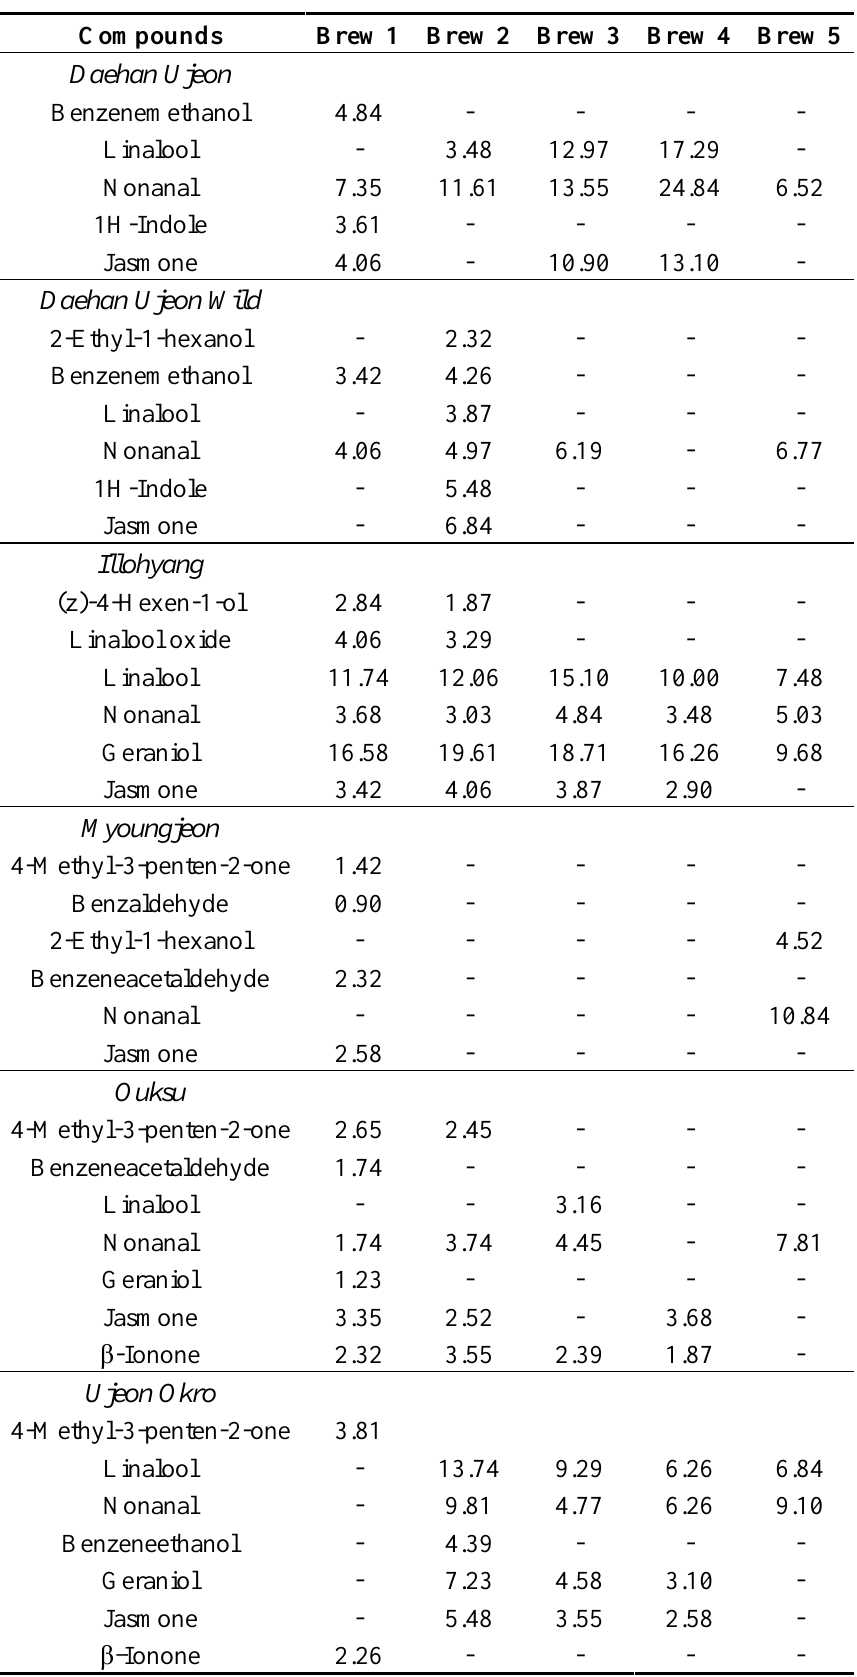
Table 4. Composition and concentration of the volatile compounds in six green teas infusion